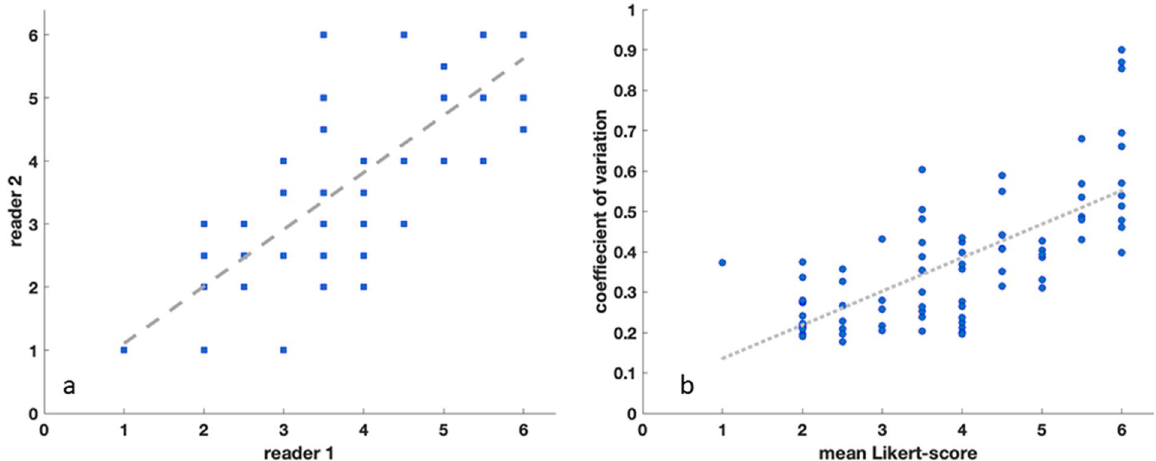
Fig. 4 Scatter plots showing the correlation of reader 1 and 2 ( a ) and the correlation of mean Likert scores and coefficients of variation ( b